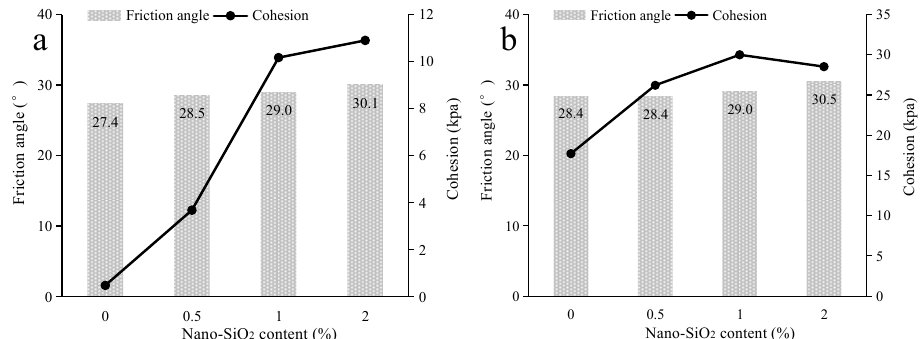
Figure 9. The shear strength parameters of nano-SiO 2 -reinforced sandy soil ( a ) under uncured conditions ( b ) under cured conditions.